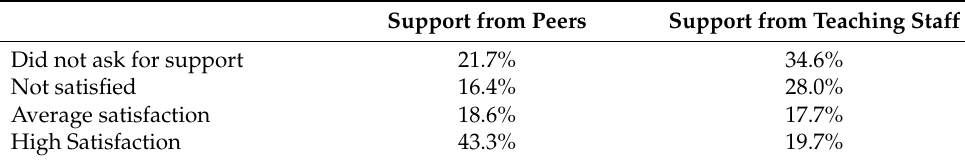
Table 3. Satisfaction with the support received from peers and teaching